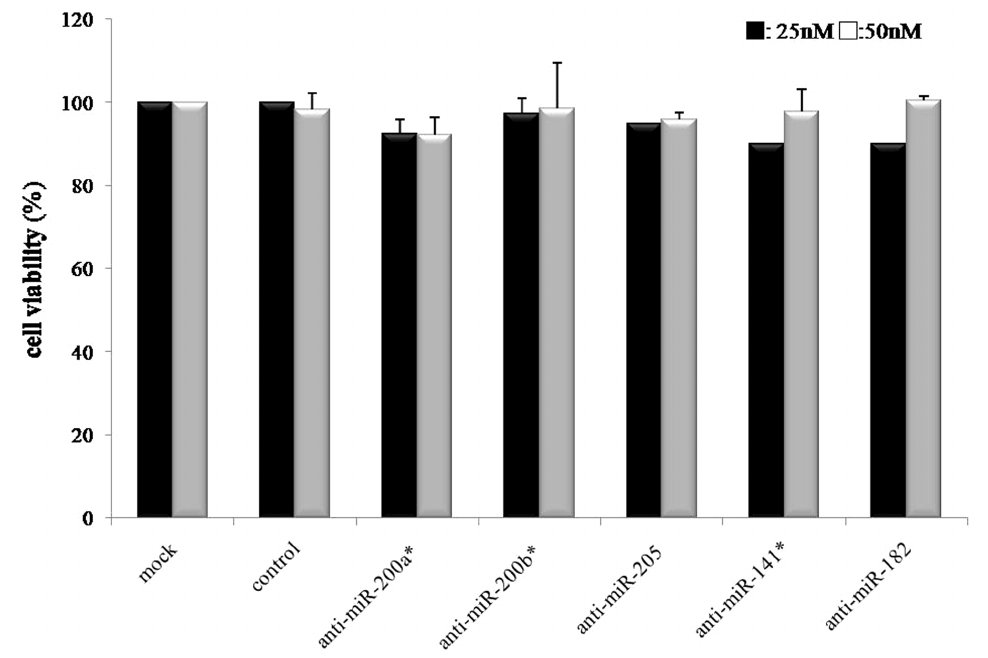
Figure 5. Cell viability assay with Hec1A cell line for the miR inhibitors at 25, 50 nM of miR inhibitors. Values are mean of three independent experiment 6 S.E. (p=NS).